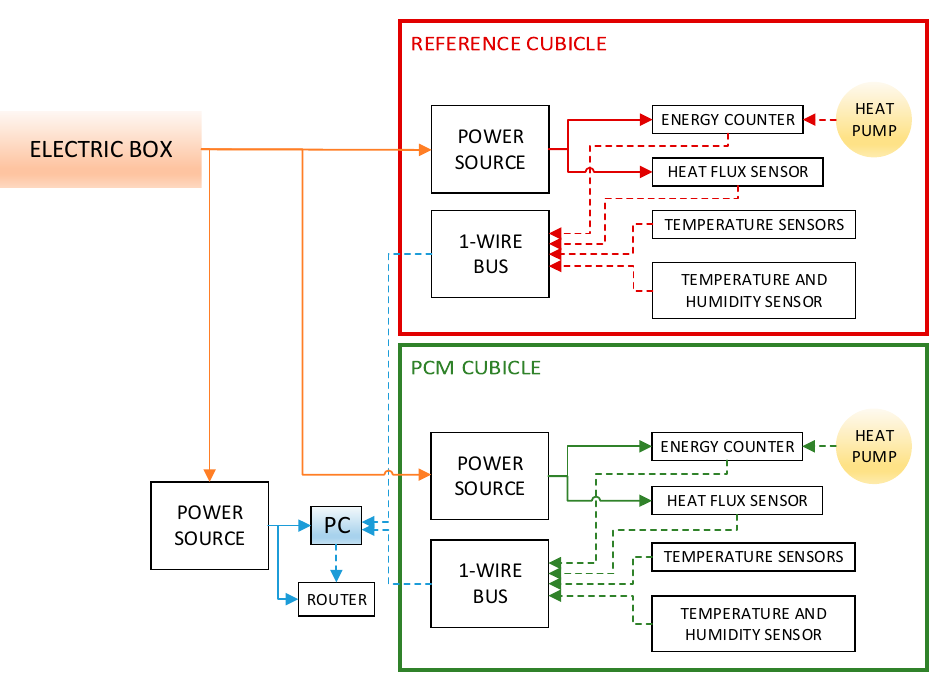
Figure 5. Data collection system and power supply.